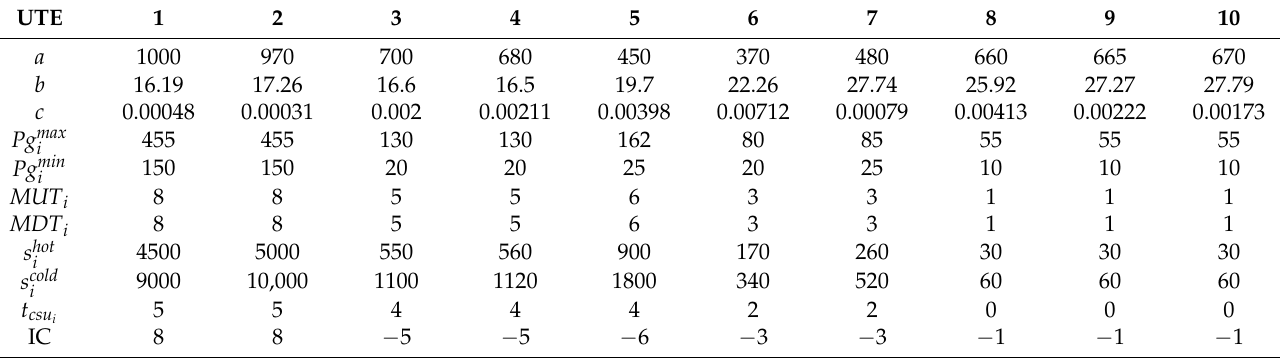
Table 3. Data of TGs.